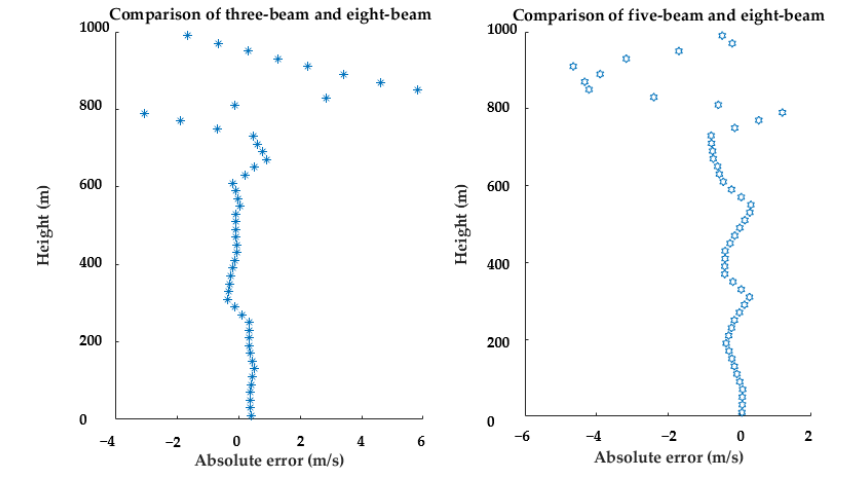
Figure 10. Variation in the absolute deviation with height between the different beam measurements.